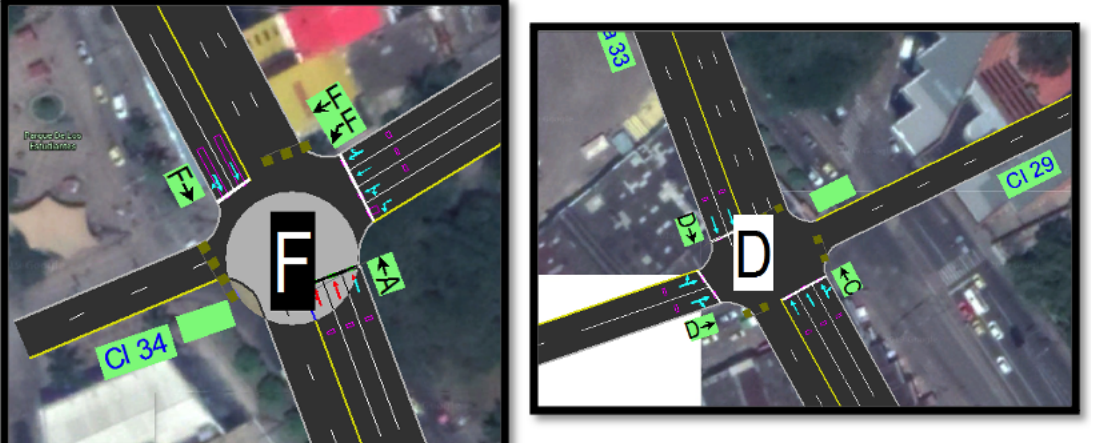
Figure 13: Level of service: Implementation of new